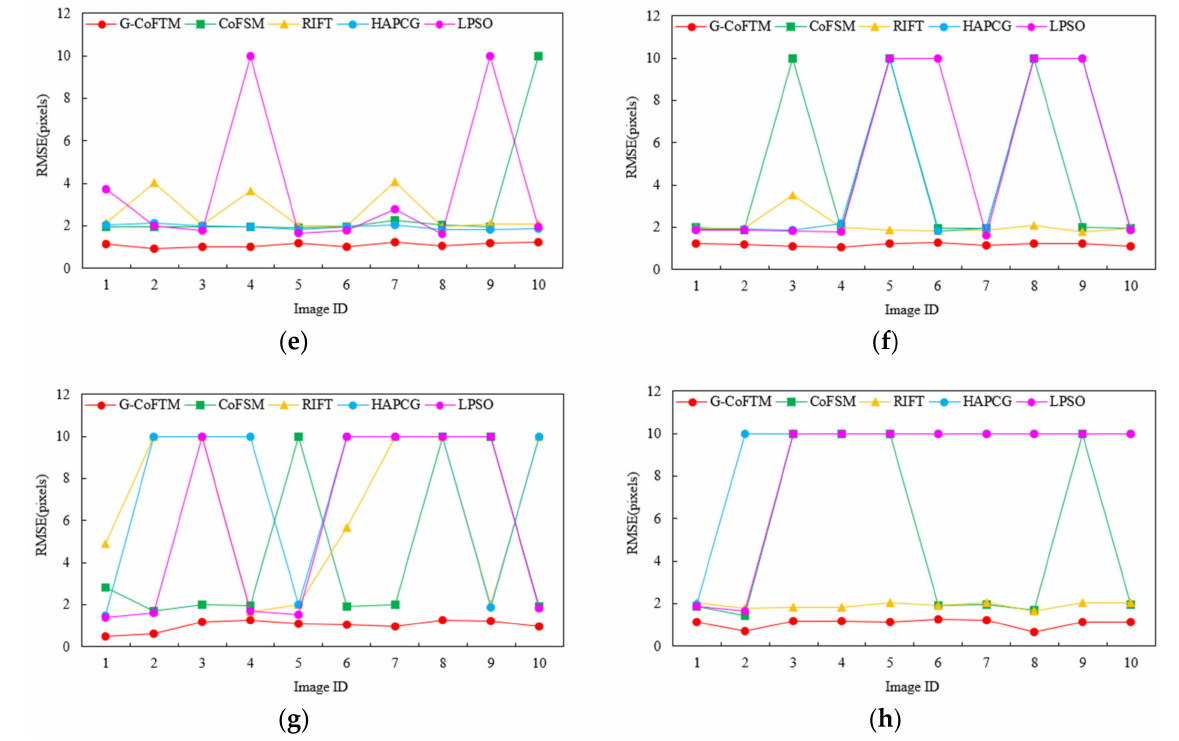
Figure 11. Comparisons on the RMSE metrics: ( a ) Optical–Optical; ( b ) Optical–Infrared; ( c ) Optical– Depth; ( d ) Optical–Map; ( e ) Optical–SAR; ( f ) Day–Night; ( g ) Scale; ( h ) Rotation. Table 7. Comparison on RMSE ave